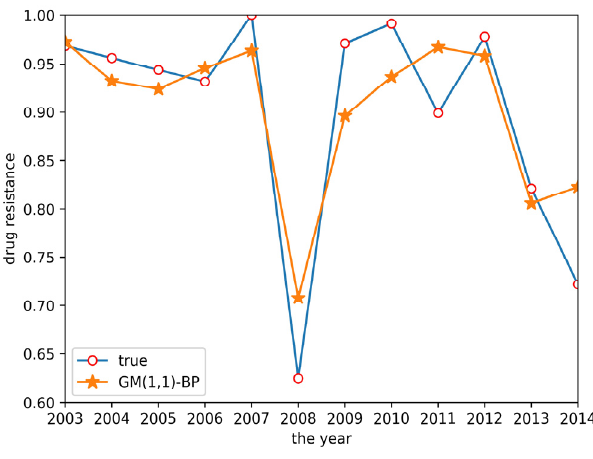
Figure 6. GM(1,1)-BP neural network prediction result.